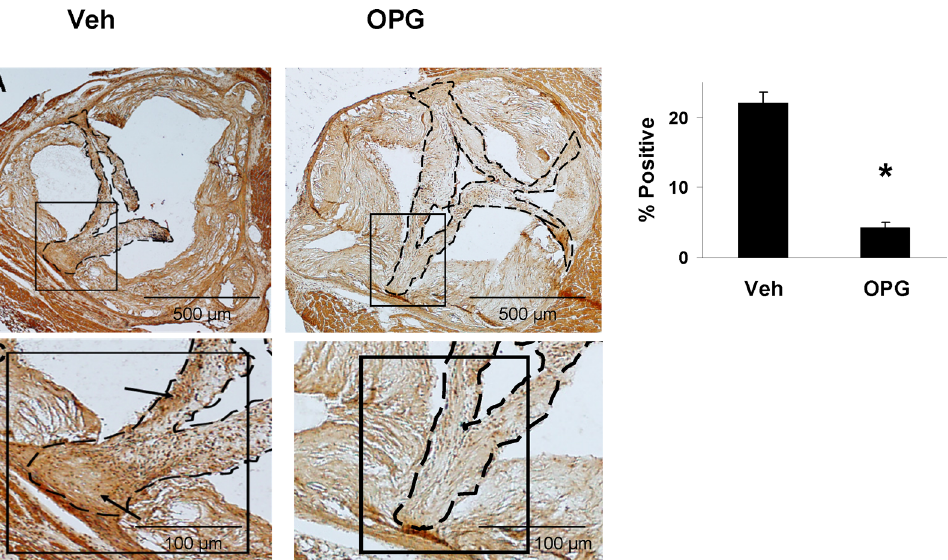
Figure 5. Immunostaining for osteocalcin in the aortic valve in Older mice. In vehicle-treated mice ( A,C ), osteocalcin (dark brown) is abundant near the cusp base (arrows). There is only scant staining in the valve of an OPG-treated mouse ( B,D ). N=4. *p , 0.05 Veh vs. OPG.